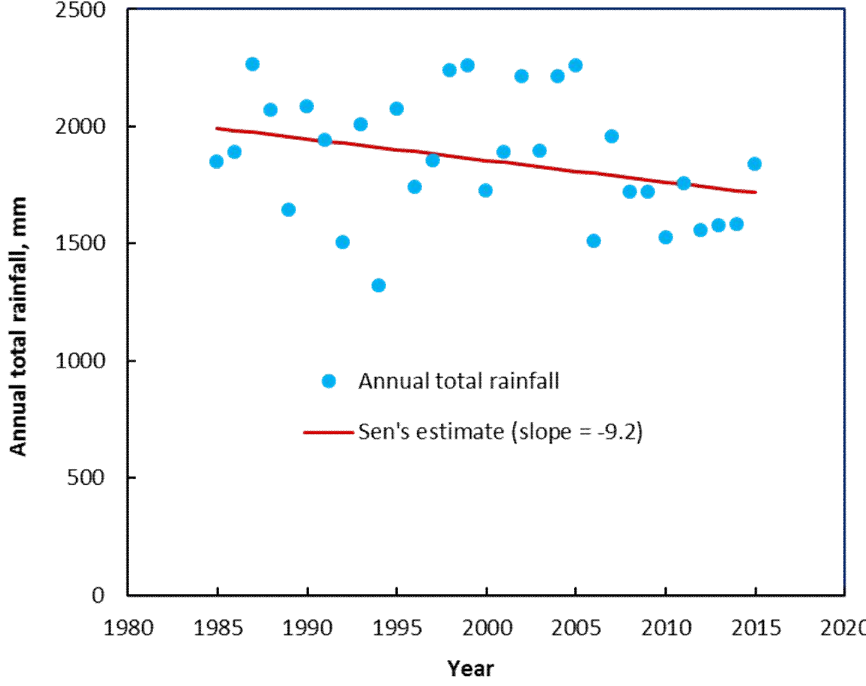
Figure 2. Variation of average annual total rainfall of six stations of the North-West Bangladesh and its trend over the years from 1985 to 2015.